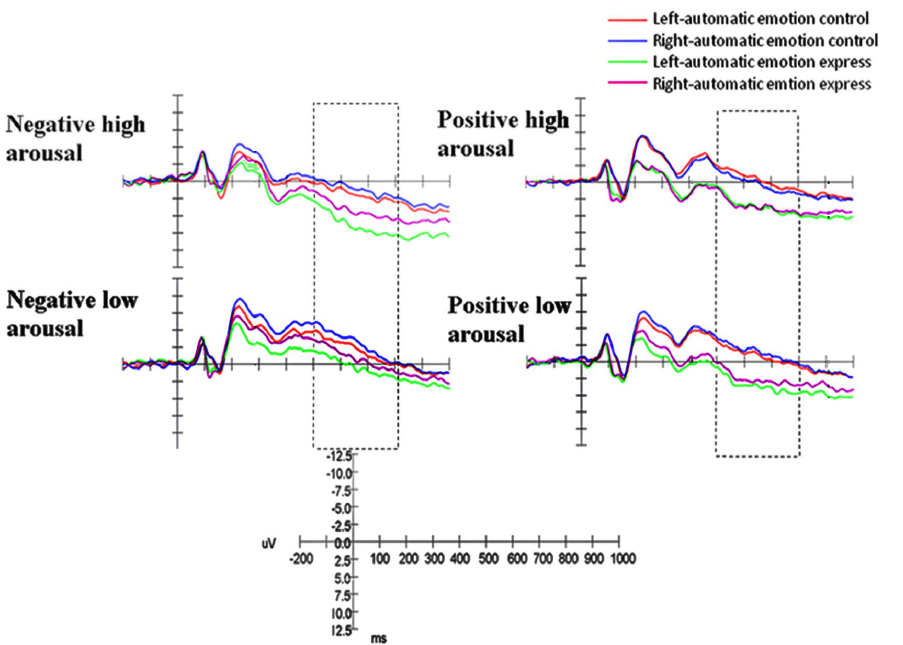
Figure 1. ERPs for automatic emotion control and automatic emotion express groups during four emotion blocks at anterior electrodes. Left=left electrodes. Right=right electrodes.